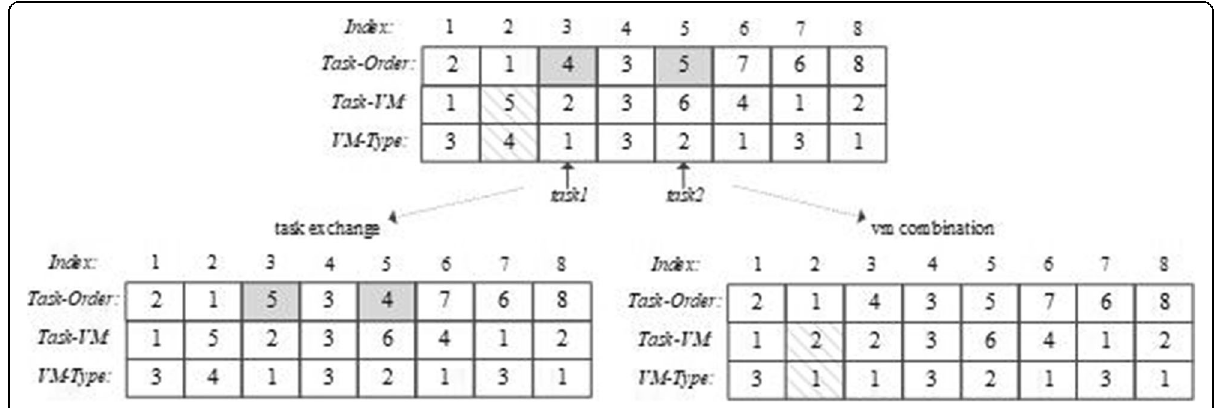
Fig. 5 An example of the mutation